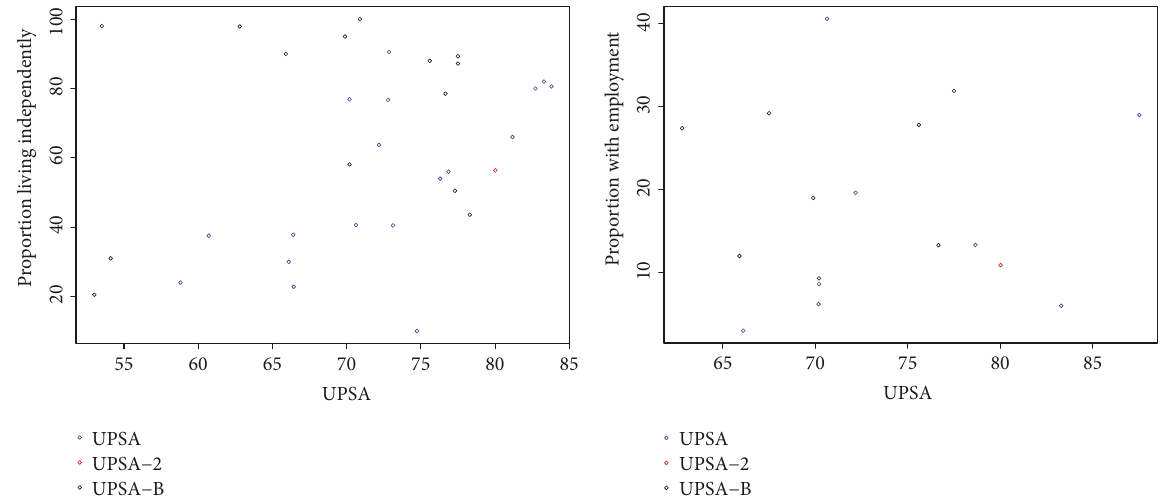
Figure 3: UPSA vs residential and employment status.